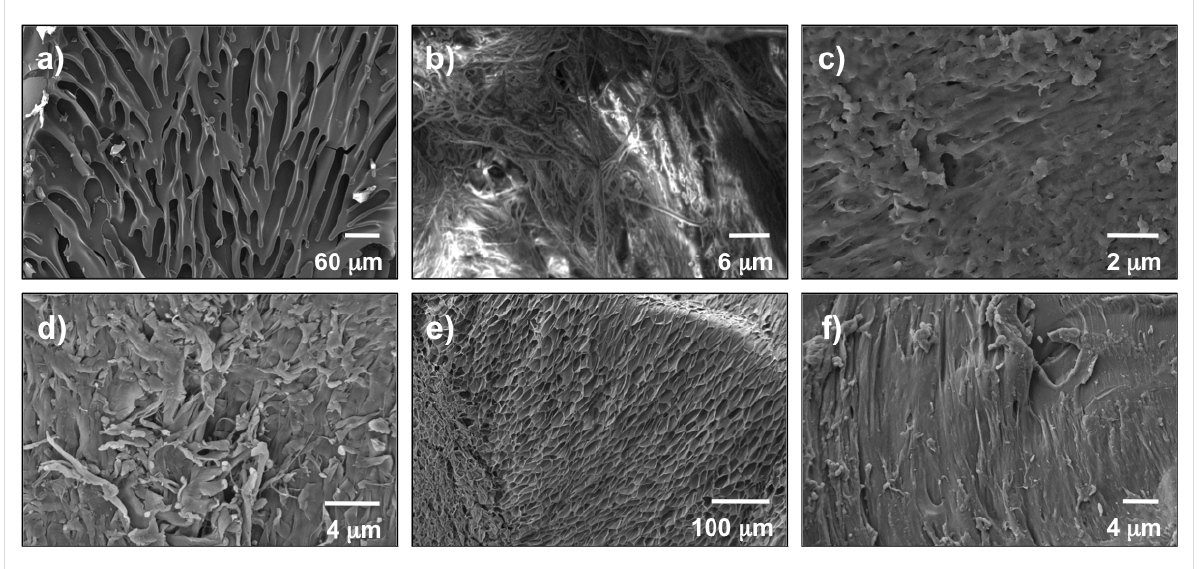
Figure 3: Selected FESEM images of different catalysts used for comparative kinetics: (a) powdered BSA; (b) powdered collagen; (c) powdered PSTA gelatin; (d) powdered chitosan; (e) xerogel prepared by freeze-drying the hydrogel made of PSTA gelatin; (f) commercial powdered edible